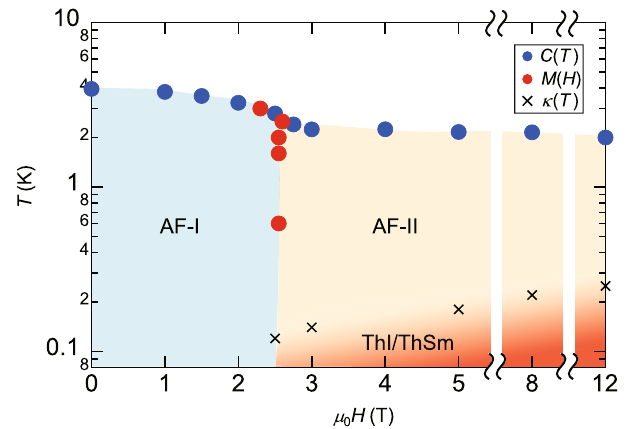
Fig. 4 Field-temperature phase diagram of YbIr 3 Si 7 for H ∥ c . The Néel temperatures ( fi lled blue circles) are determined by the peak temperature of C ( T )/ T and phase boundary ( fi lled red circles) is determined by the peak of d M /d H . In the AF-I phase, the spins are oriented along the c axis. The AF-II phase is in the spin- fl op phase, where the spins are oriented in the ab plane. The crosses represent the temperatures at which gap formation occurs, which is determined by the deviation of κ / T from T 2 -dependence shown by arrows in Fig. 8d – h. The red-colored regime represents thermal insulator or thermal semimetal (ThI/ThSm) regime.